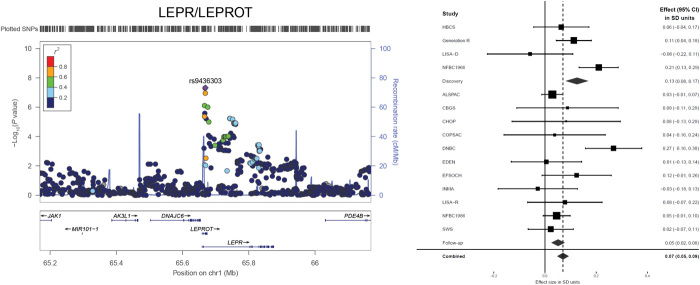
Regional association and forest plot of the novel genome-wide significant locus associated with BMI-AP.Purple diamond indicates the most significantly associated SNP in stage 1 meta-analysis, and circles represent the other SNPs in the region, with coloring from blue to red corresponding to r2 values from 0 to 1 with the index SNP. The SNP position refers to the National Center for Biotechnology Information (NCBI) build 36. Estimated recombination rates are from HapMap build 36. Forest plots from the meta-analysis for each of the identified loci are plotted abreast. Effect size [95% confidence interval (CI)] in each individual study, discovery, follow-up, and combined meta-analysis stages is presented from fixed-effects models (heterogeneity of the SNP rs9436303 in LEPR/LEPROT; see fig. S6). At this locus, there was heterogeneity between the studies in discovery (I2 = 72.1%, P = 0.01) and combined stage (I2 = 59.3%, P = 0.002) fixed-effects meta-analyses that was mainly due to LISA-D, EDEN, and the larger well-defined NFBC1966 study (fig. S6, A and D). Removing the studies that showed inflated results from meta-analyses did not change the point estimates (fig. S6, C, F, and G). Both fixed- and random-effects models gave very similar results (fig. S6, B and E).